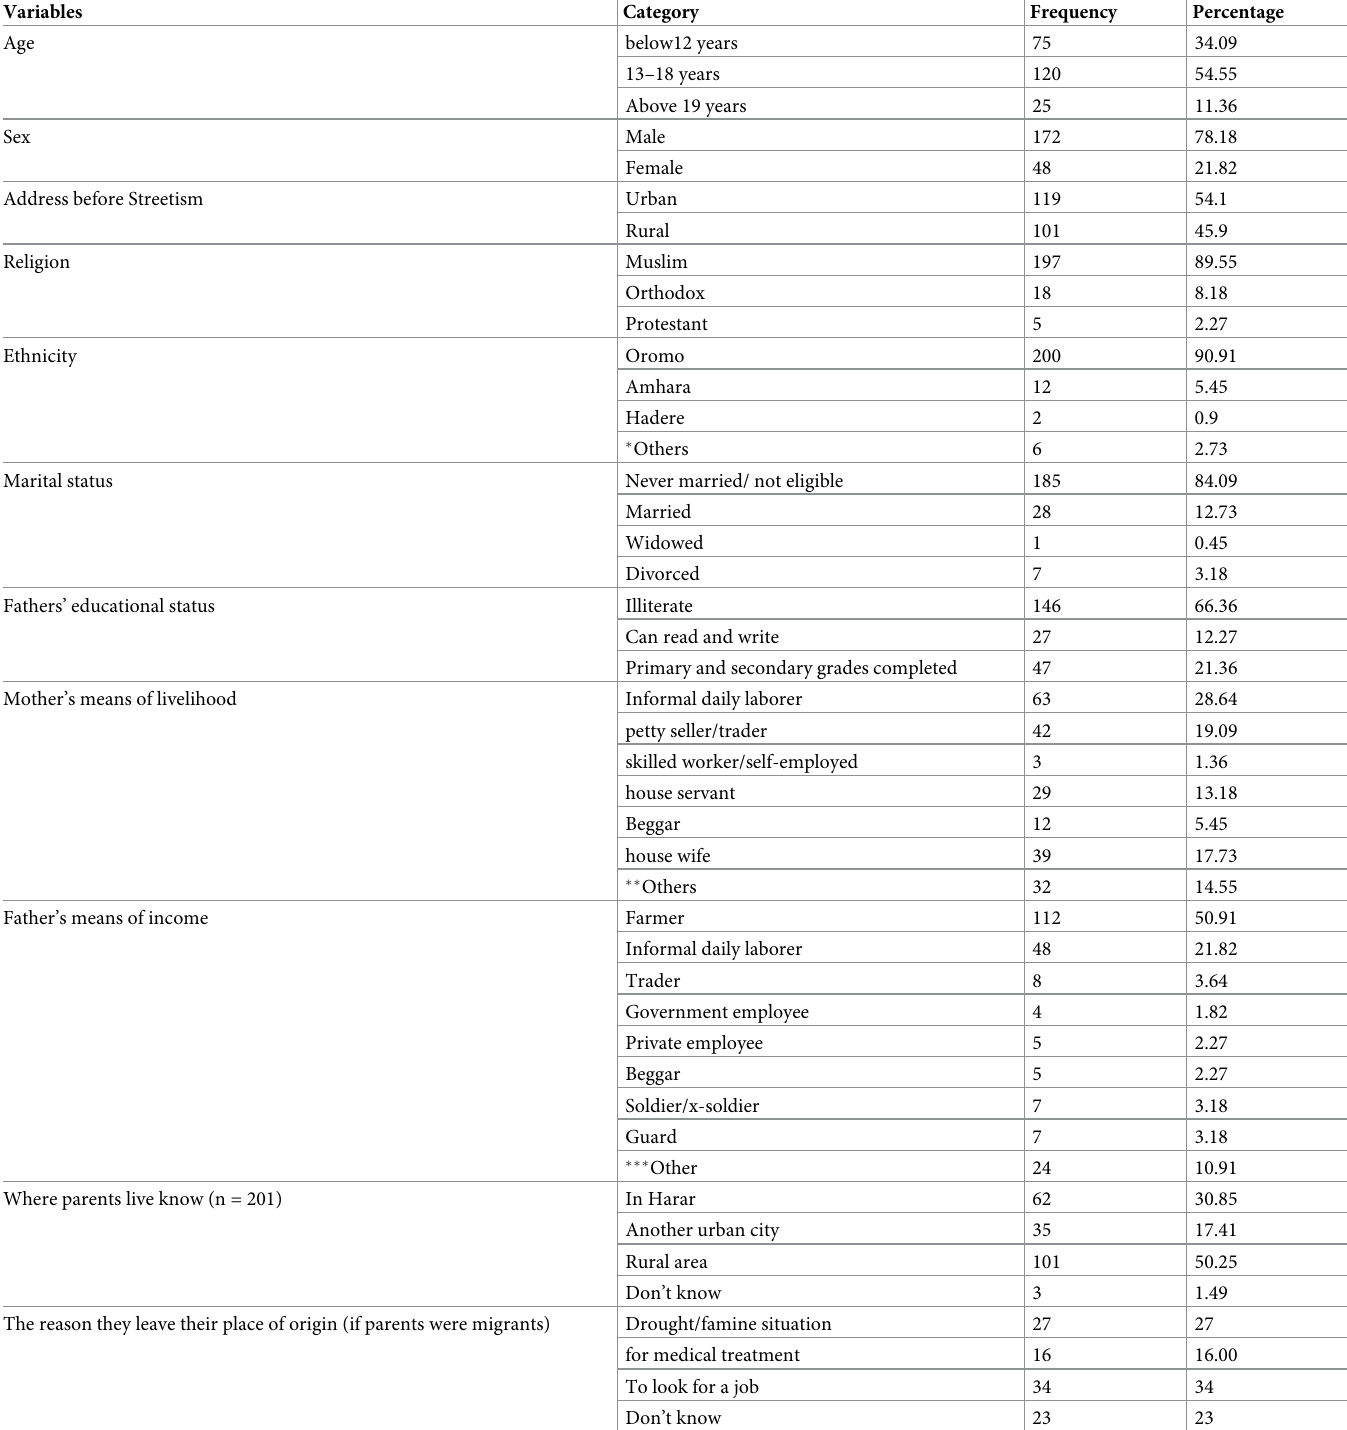
Table 1. Socio-demographic characteristics of the study participants and their parents in Harar, Eastern Ethiopia, 2021 (n =